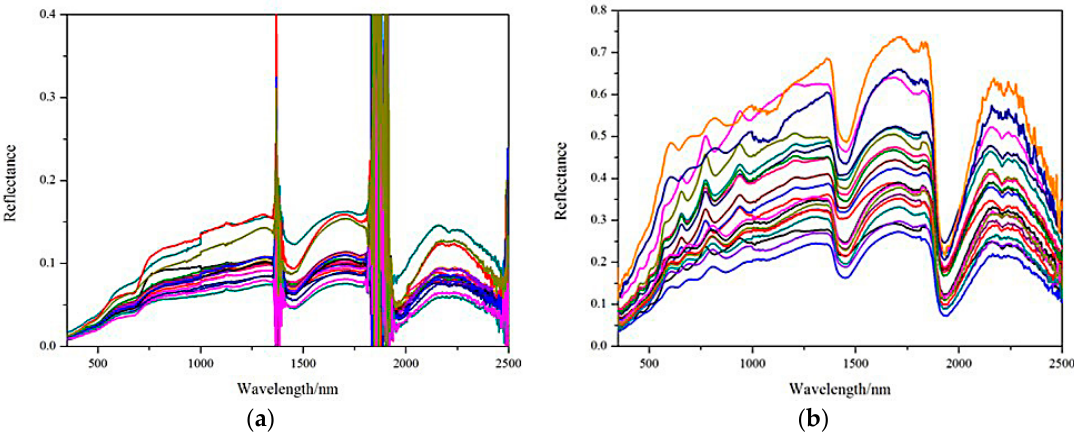
Figure 2. Original outdoor ( a ) and indoor ( b ) spectra of mine reclamation soils.